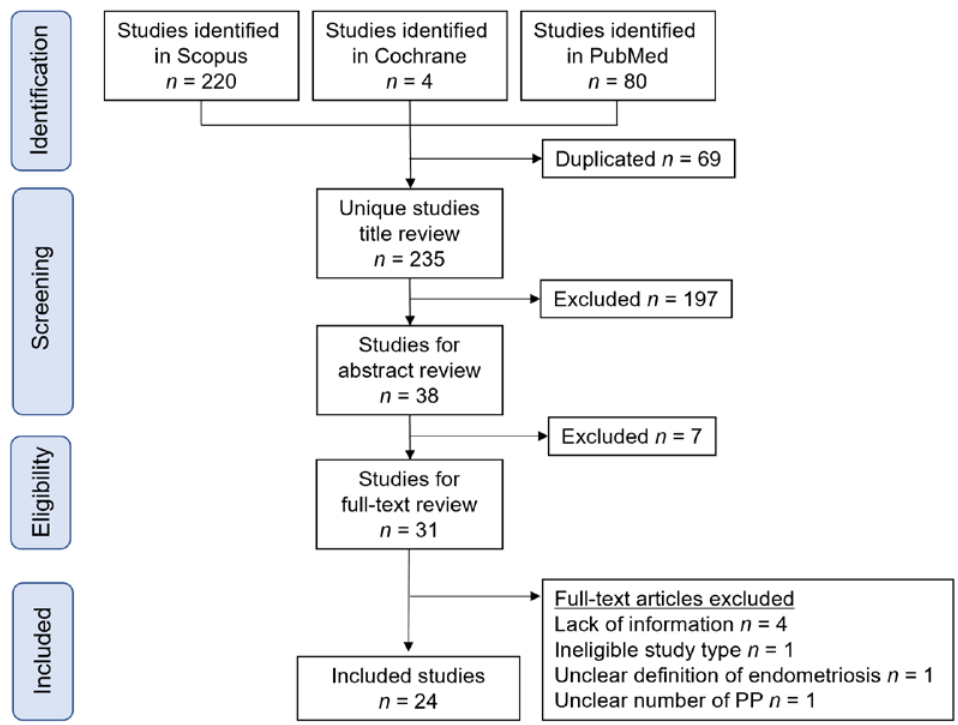
Figure 2. Study selection scheme of the systematic search of articles. Abbreviation: PP, placenta pre- via.